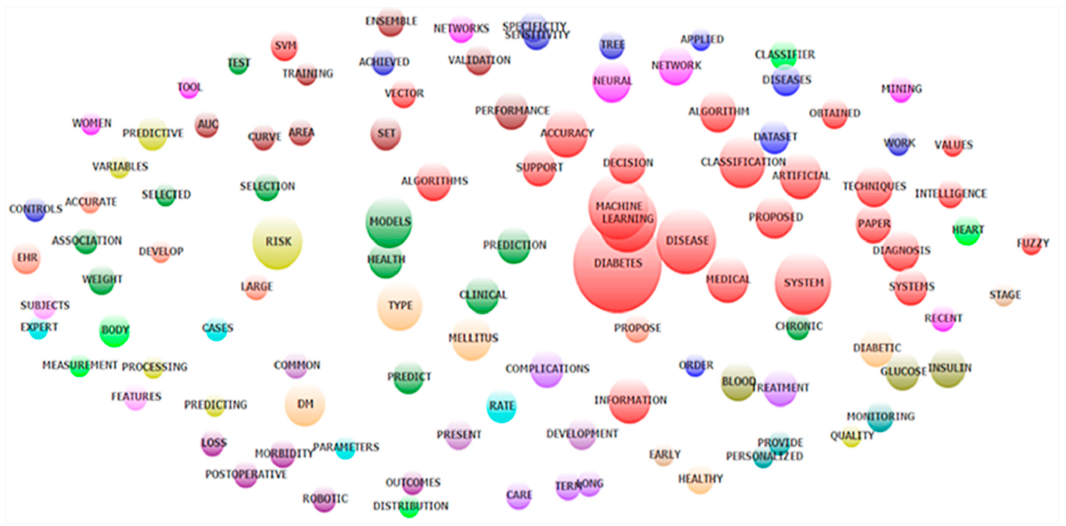
Figure 2. Co-occurrence of most frequent topics emerged from exploratory factor analysis of abstracts contents.